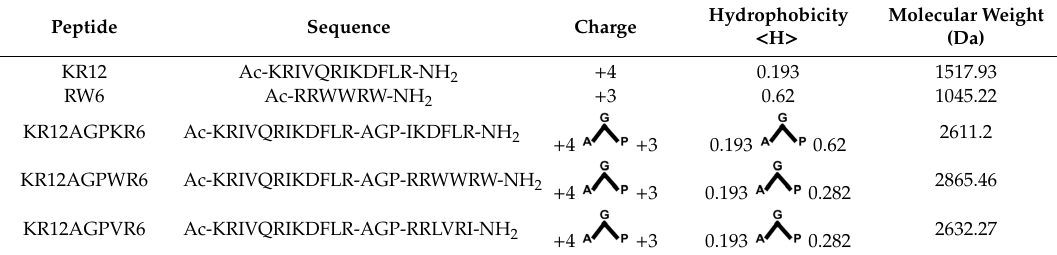
Table 1. Primary structure, charge, hydrophobicity and molecular weight of Ala-Gly-Pro (AGP) series peptides. Peptide